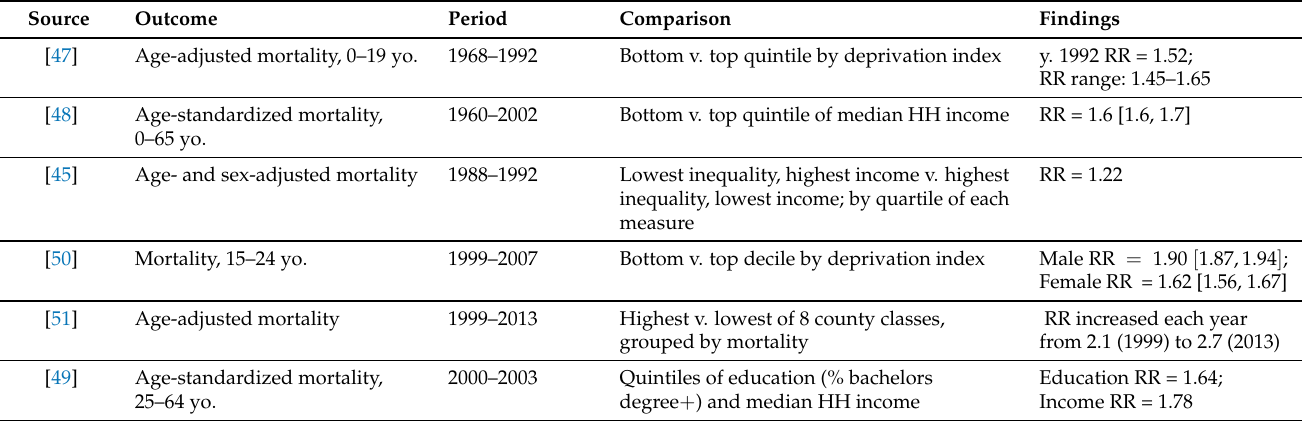
Table A1. Summary of select published findings on inequality in all-cause county mortality. Source Outcome Period Comparison Findings Bottom v. top quintile by deprivation index y. 1992 RR = 1.52; RR range: